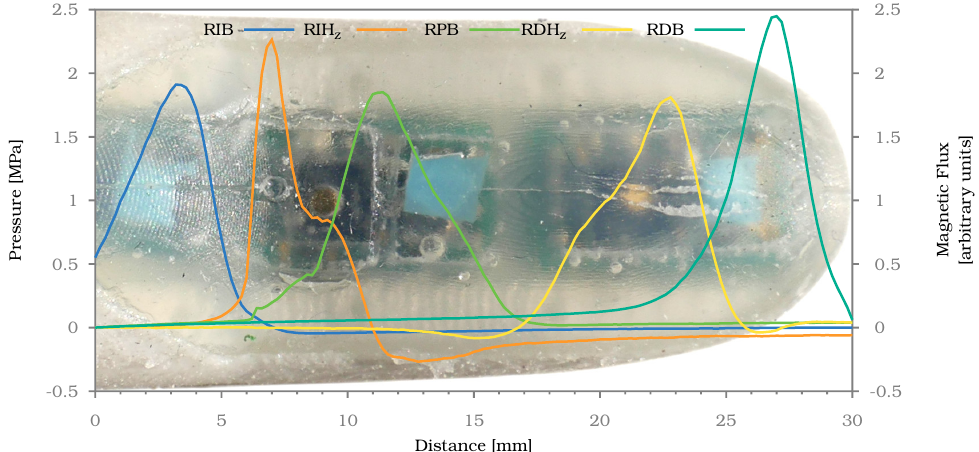
Figure 15. Normal force signals for sensors of the ring finger while probed with 2N of normal force along the axis from the proximal end of the fingertip to the distal end. The background image shows the approximate position of the probe on the finger at the time of each